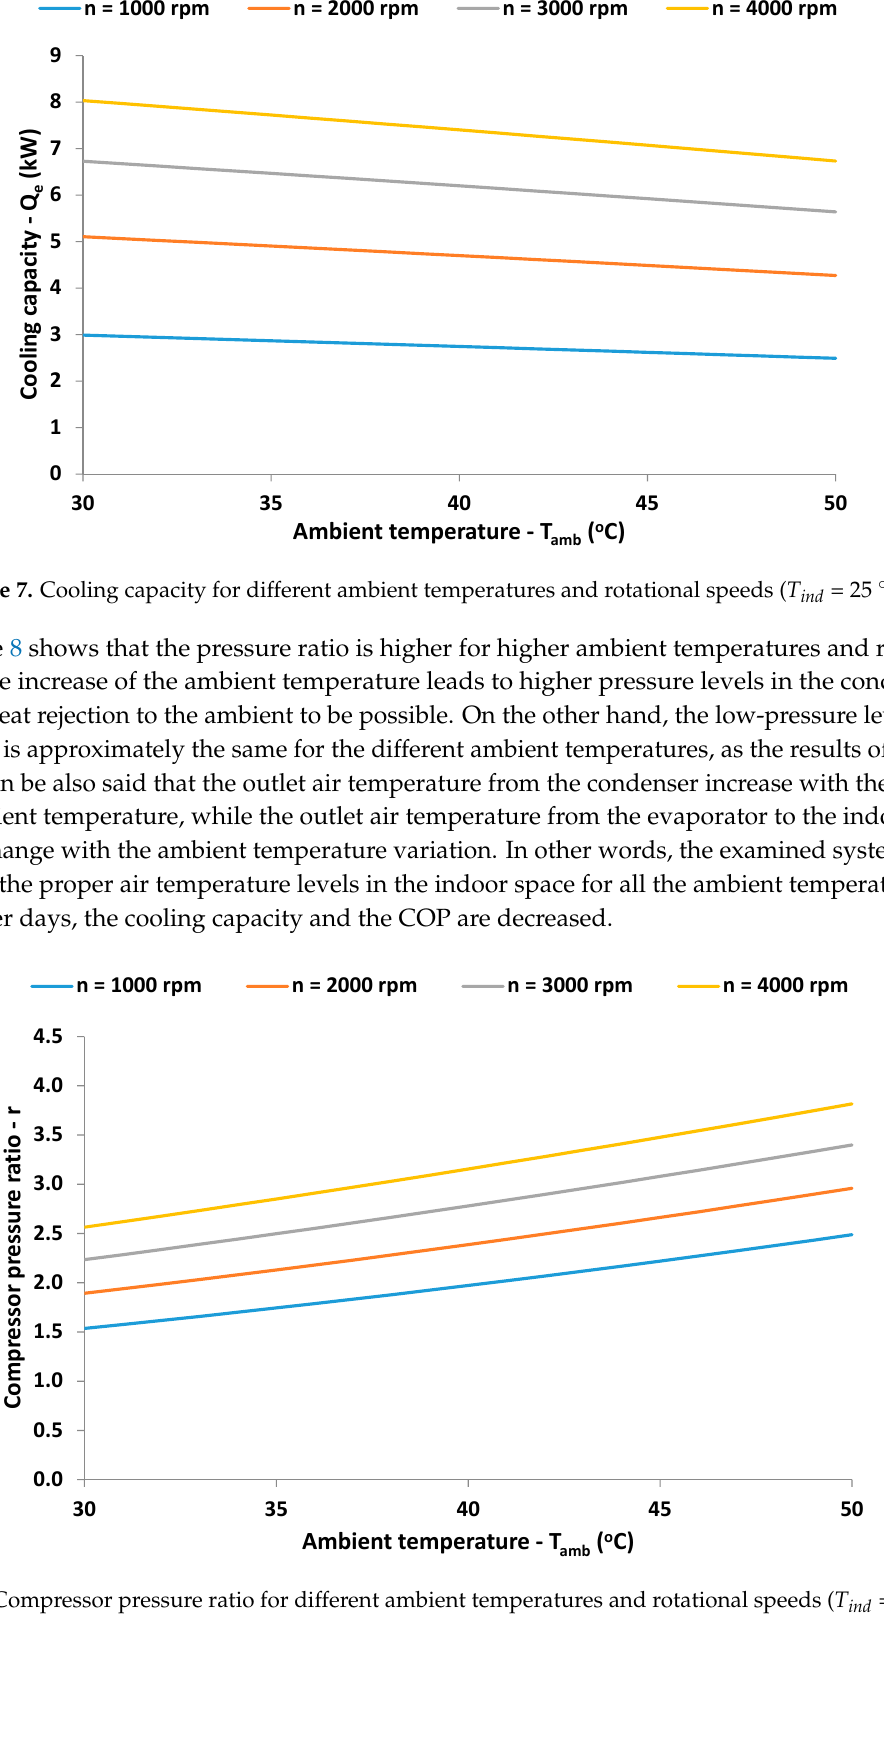
Figure 8. Compressor pressure ratio for different ambient temperatures and rotational speeds ( T ind = 25 °C).